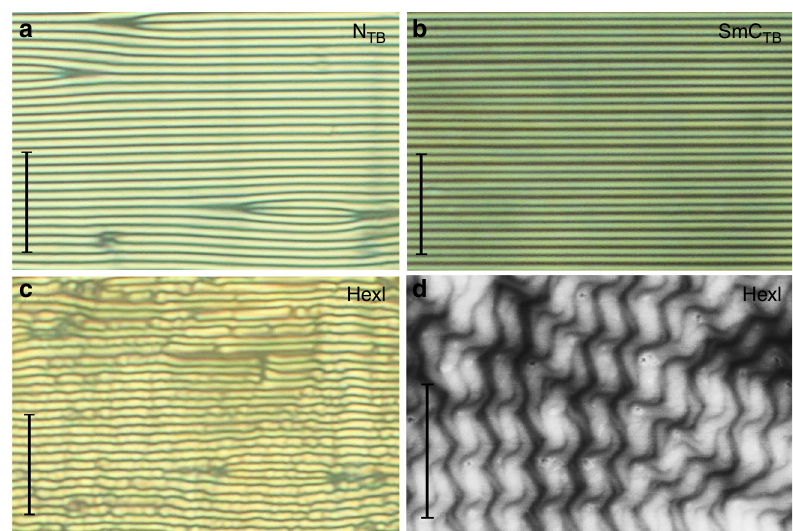
Fig. 3 Optical textures. Stripe textures observed in the 1.9 micron cells with planar anchoring for a N TB phase of CB6OIBeO6, b SmC TB phase of CB6OIBeO7 and c HexI phase of CB6OIBeO6. d AFM image of twisted entangled fi laments formed in the temperature range of the HexI phase for homologue CB6OIBeO7. Scale bars in a – c correspond to 20 μ m, whereas in d to 500